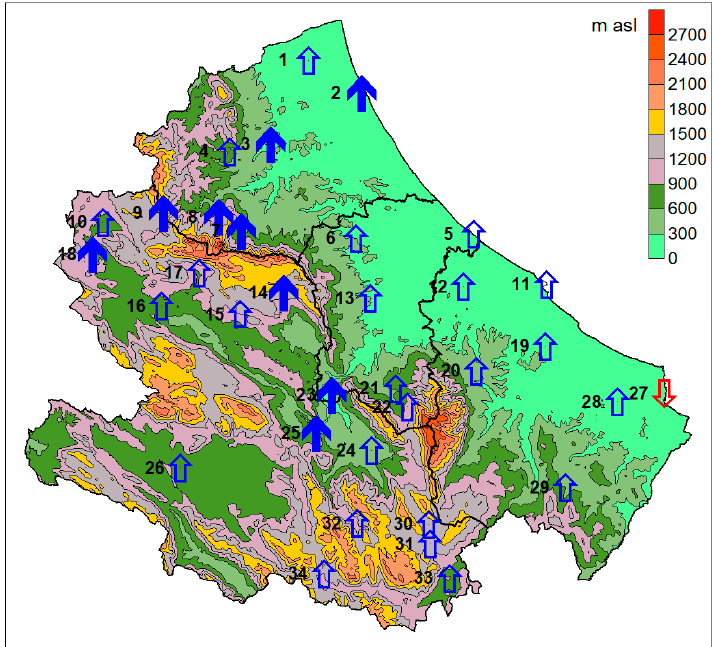
Figure 5. Trends in rainfall from April to September. The downward arrows indicate decreasing trends, while the upward arrows indicate increasing trends. Full arrows indicate significant trends with p < 0.05, while empty arrows indicate no significance. The number next to the arrow indicates the numeric code of the meteorological station. The red arrows represent a trend of decrease in rain, while the blue arrows represent a trend of increase in rain. The altitude classes are given on the upper right .